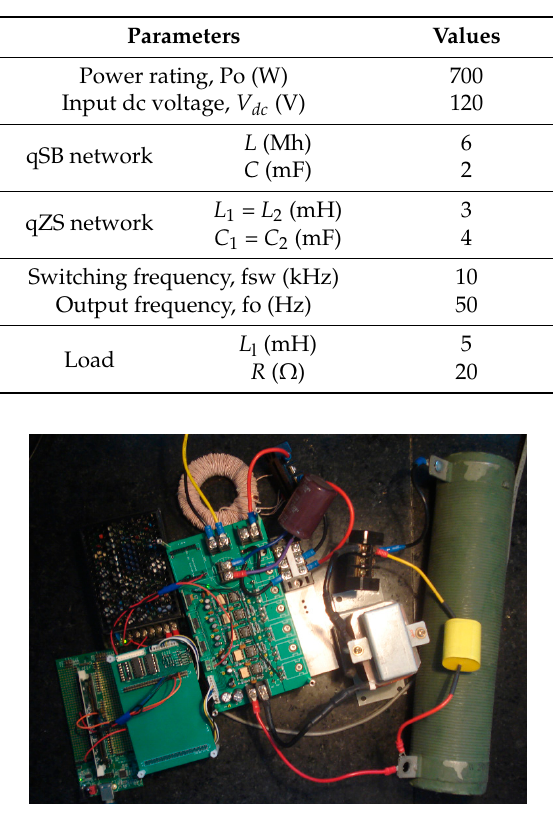
Figure 7. Experimental prototype in the laboratory.